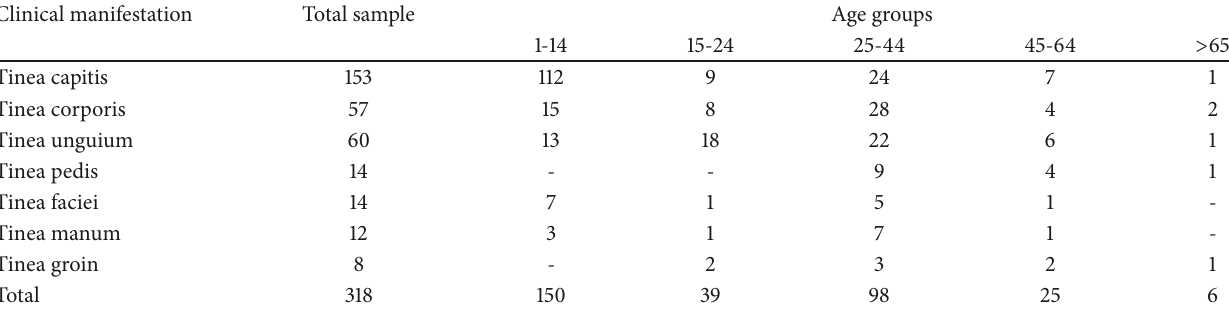
Table 3: Frequency of clinical manifestation in different age groups